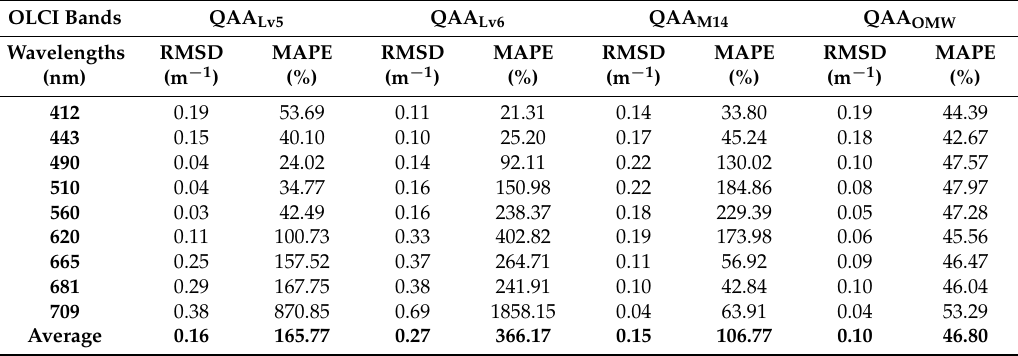
Table 6. Comparative band-specific errors related to the re-parameterization of a φ ( λ ) based on MAPE (%) and RSMD (m − 1 ) metrics. The first column represents the nominal OLCI center bands